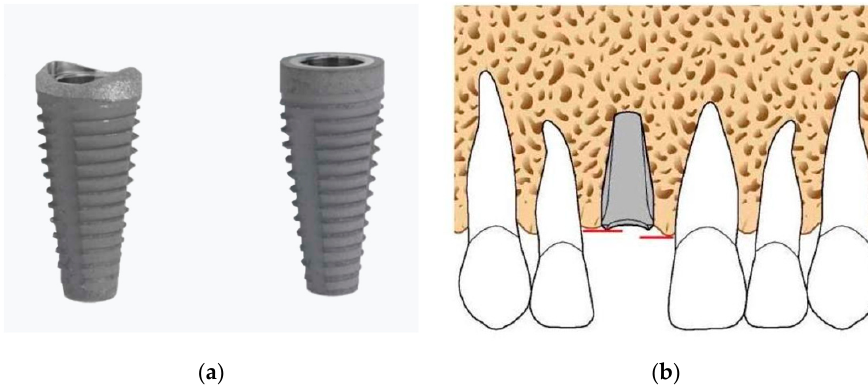
Figure 2. ( a ) Image of both bone system dental implant fixtures (left: scalloped shoulder design,